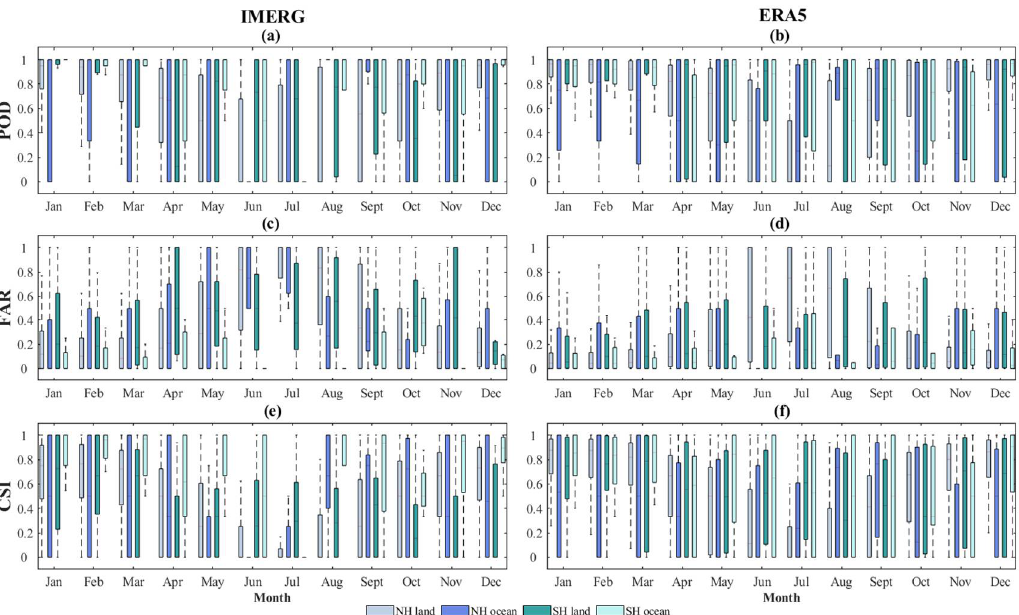
Figure 4. Boxplots of metrics for ERA5 and IMERG (2000–2007) over NH land, NH ocean, SH land and SH ocean, separately. The subplots ( a , c , e ) refer to the POD, FAR, and CSI metrics for IMERG from January to December. The subplots ( b , d , f ) refer to the POD, FAR, and CSI metrics for ERA5 from January to December.